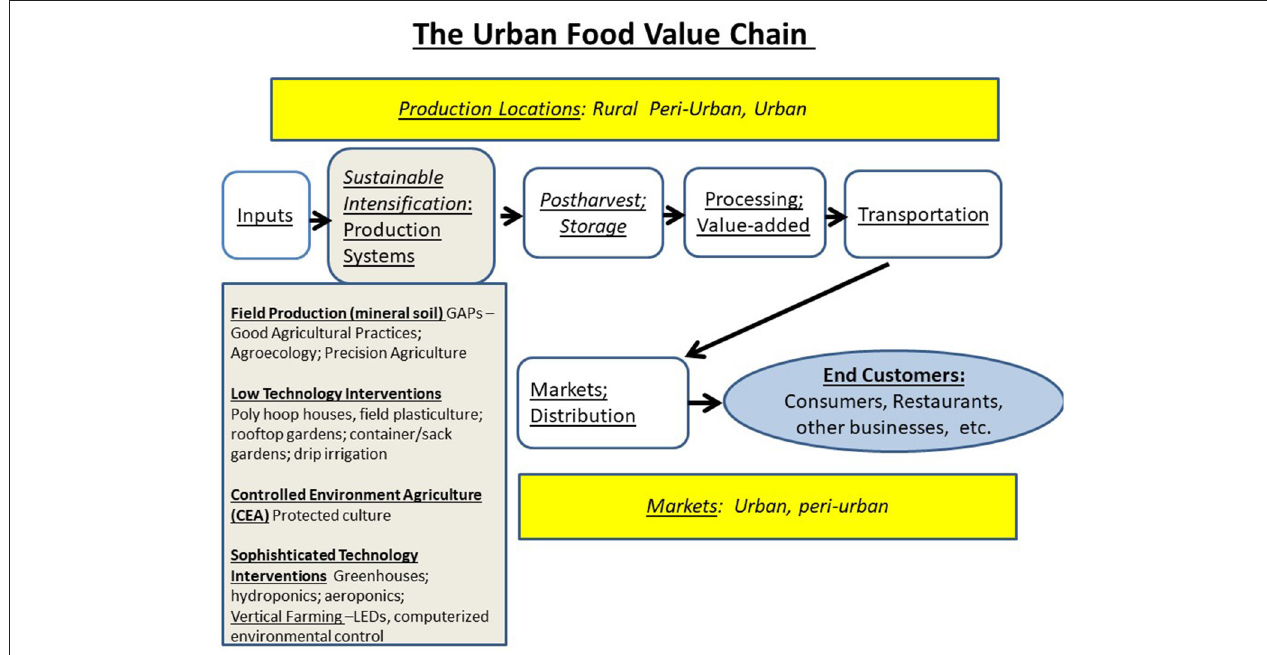
FIGURE 1 | The urban food value chain nodes from rural, peri-urban, and urban producers to servicing end customers in urban and peri-urban